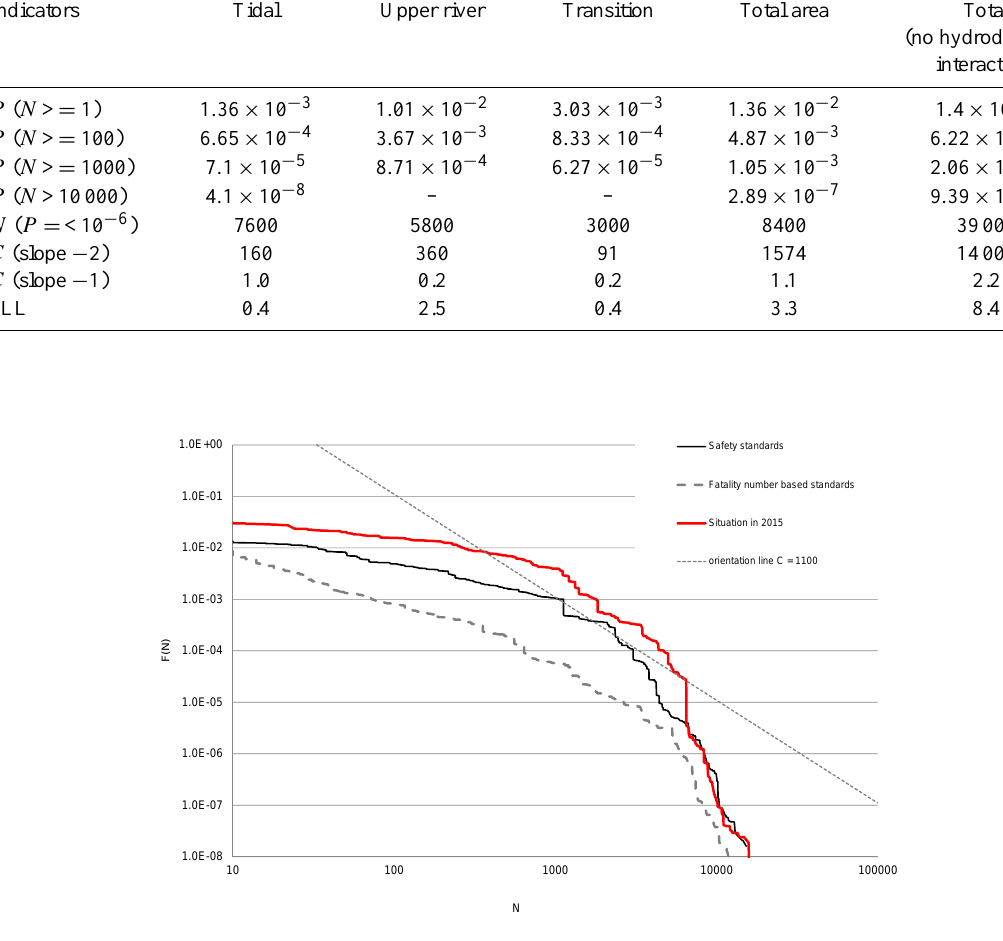
Figure 8. Resulting FN curves for the three alternative flood protection standard sets and an orientation